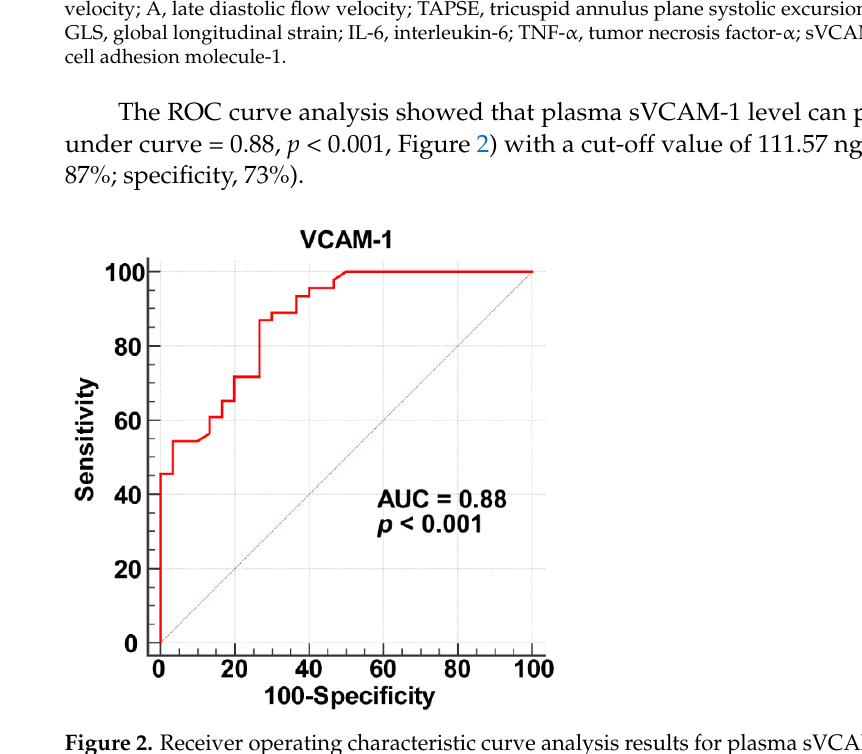
Figure 2. Receiver operating characteristic curve analysis results for plasma sVCAM-1 as a bi- omarker of